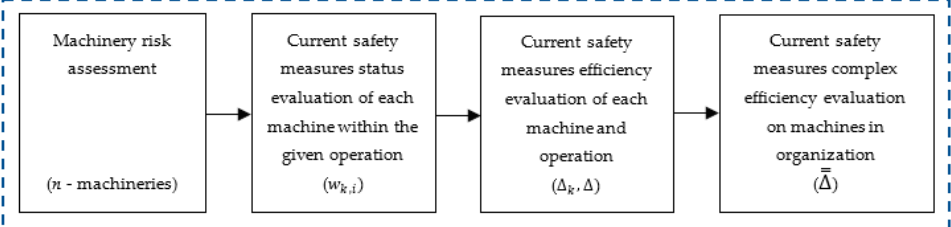
Figure 2. Proposal of the analytical procedure for the complex efficiency evaluation of machinery safety measures in a production